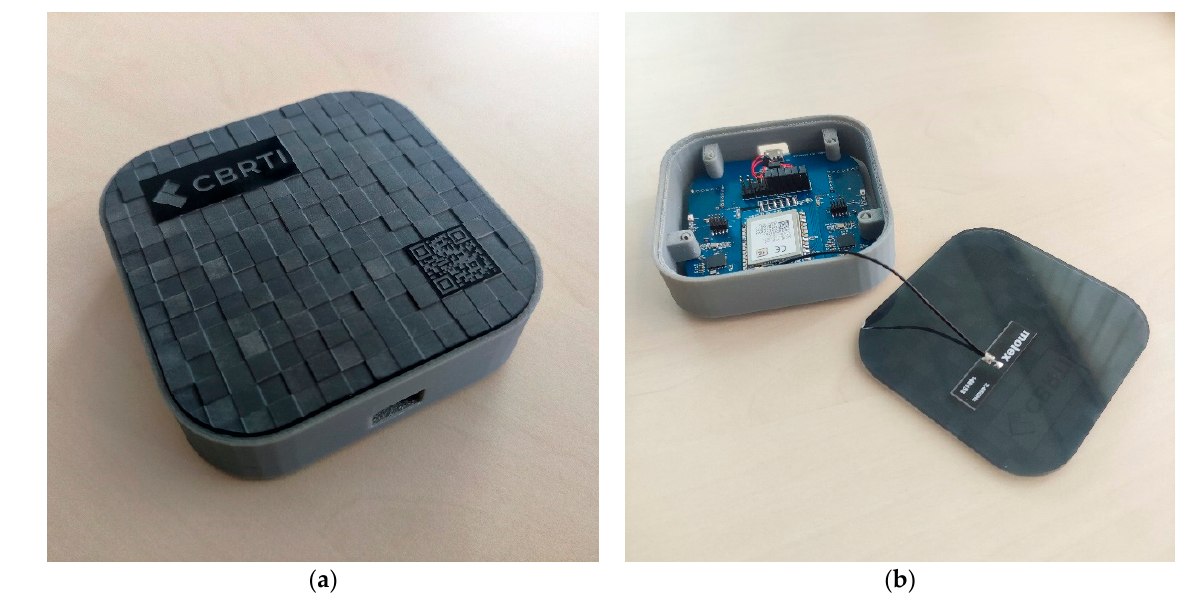
Figure 4. The appearance of the actual, complete prototype radio probe designed by CBRTI Sp. z o.o. Research and Development Center: ( a ) with the housing closed, ( b ) with the housing open.